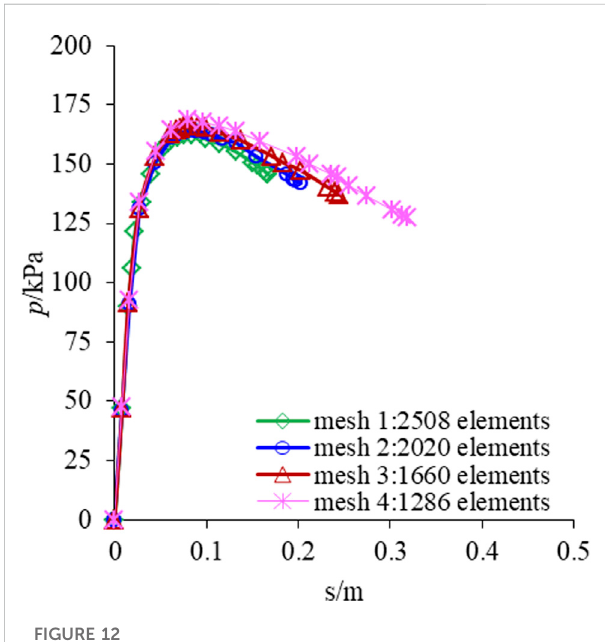
FIGURE 12 The p - s curves simulated by classical elastic-plastic fi nite element